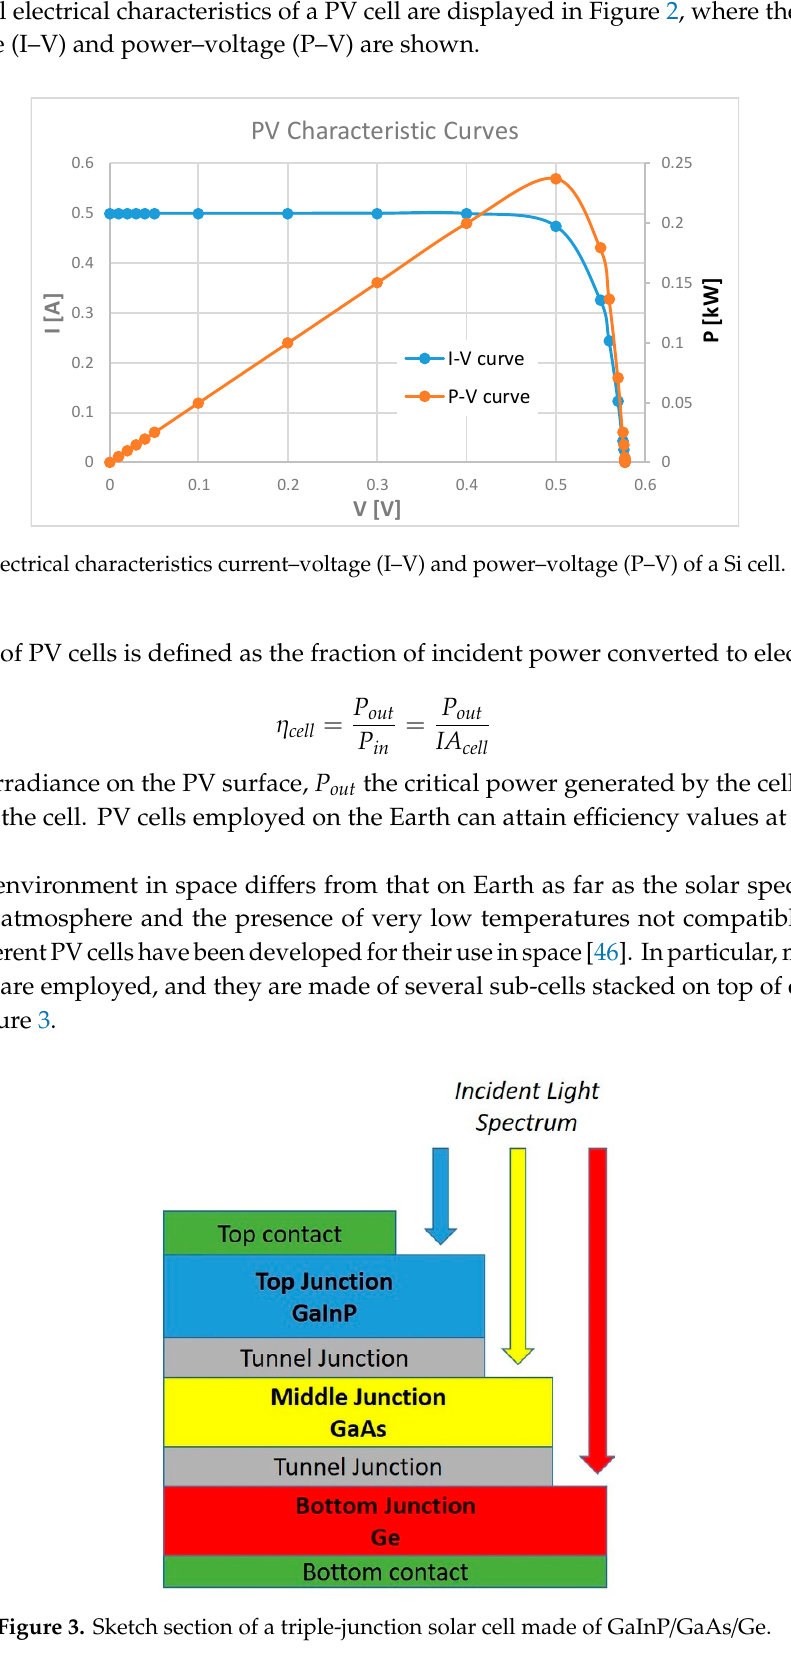
Figure 3. Sketch section of a triple-junction solar cell made of GaInP/GaAs/Ge.